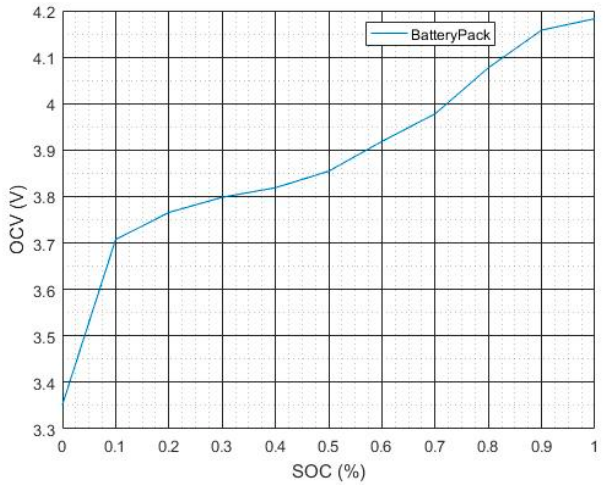
Figure 2. Open circuit voltage–state of charge (OCV–SOC) curve.